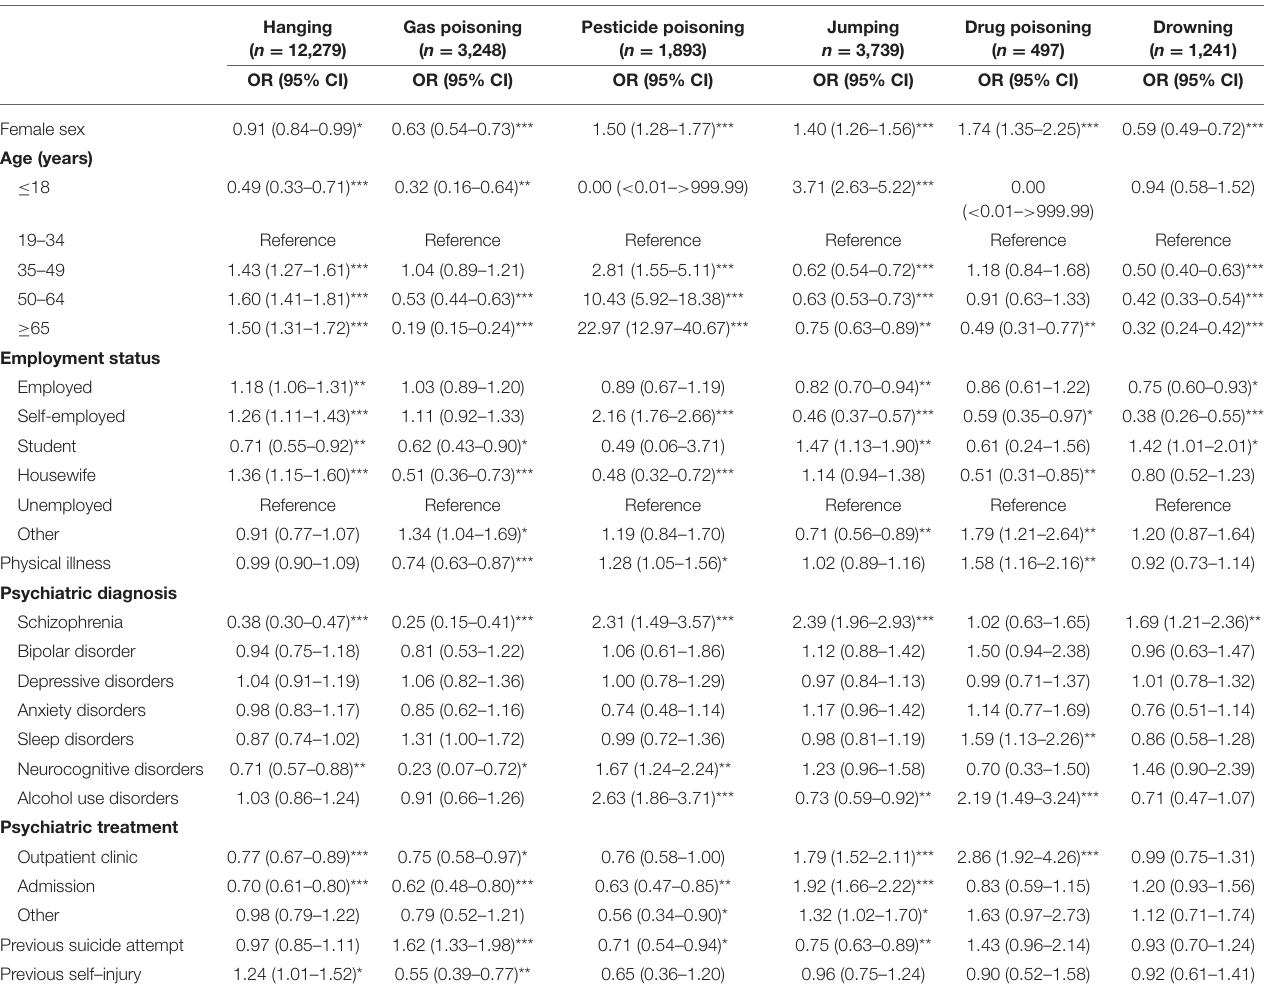
TABLE 3 | Adjusted odds ratios of potential risk factors for each method of